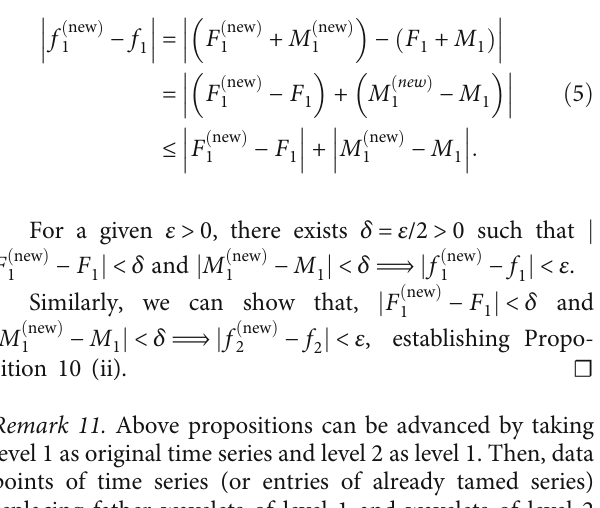
Figure 4: Qualitative illustration of taming two close time series (four two-tuples are shown): f — new father wavelet, m 2, f ð new Þ